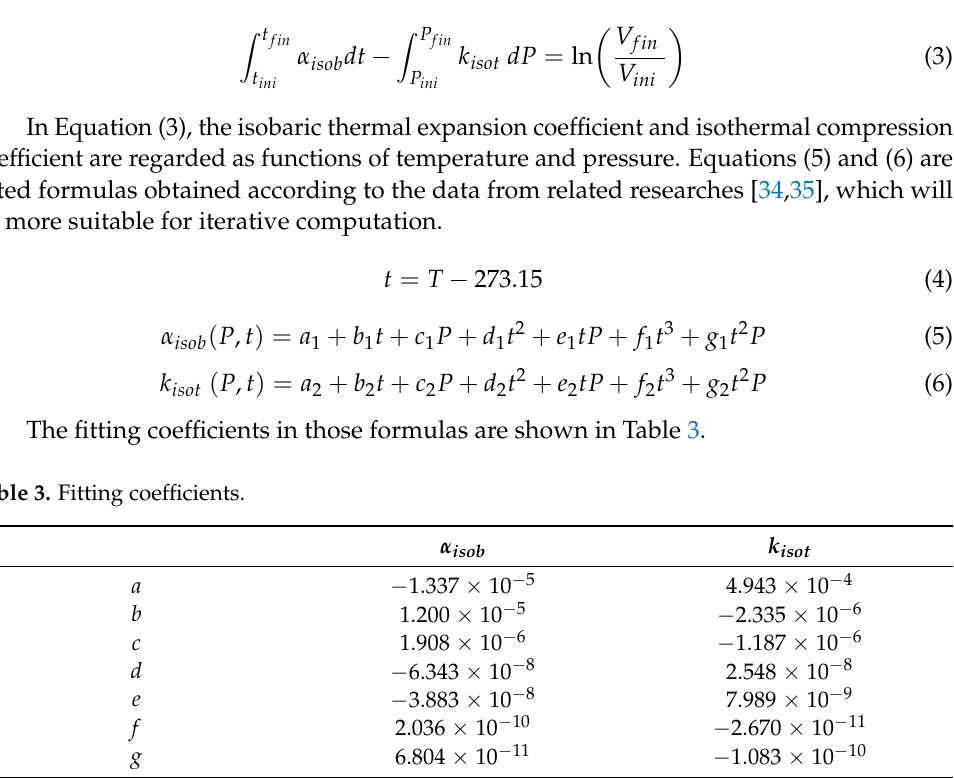
Figure 8. APB stepwise process diagram.